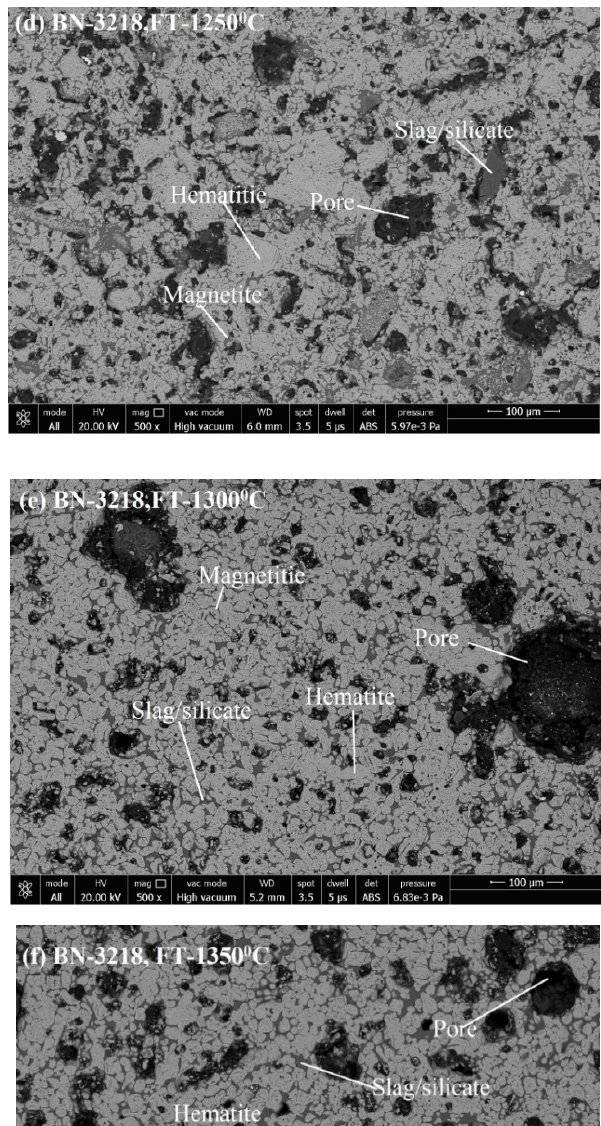
Figure 5. SEM Microstructure of ( a ) K1A, ( b ) K1B, ( c ) K1C, ( d ) K2A, ( e ) K2B, and ( f ) K2C pellets.